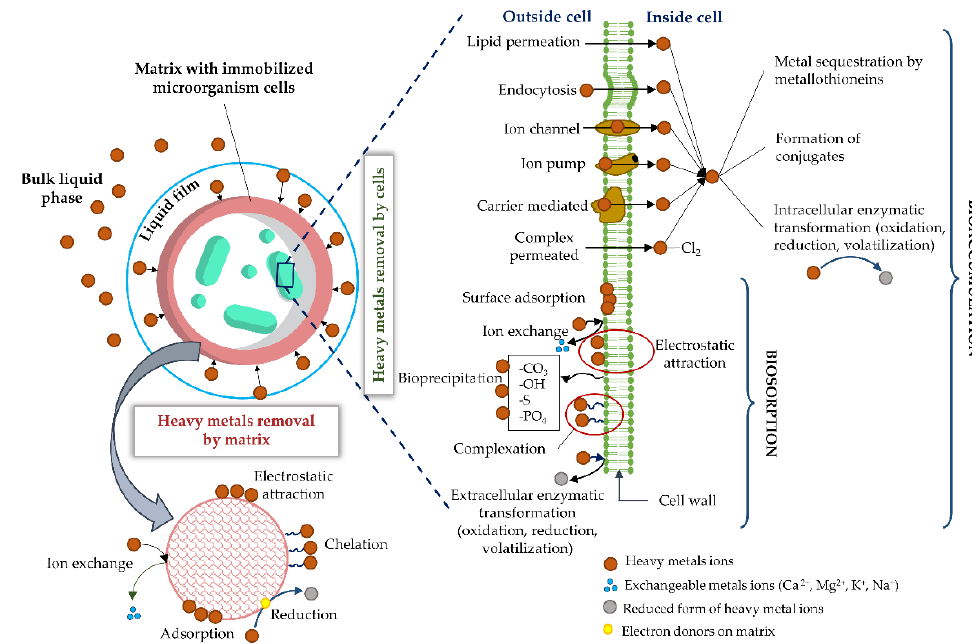
Figure 3. Mechanisms involved in heavy metals removal by a matrix with immobilized microbial cells.